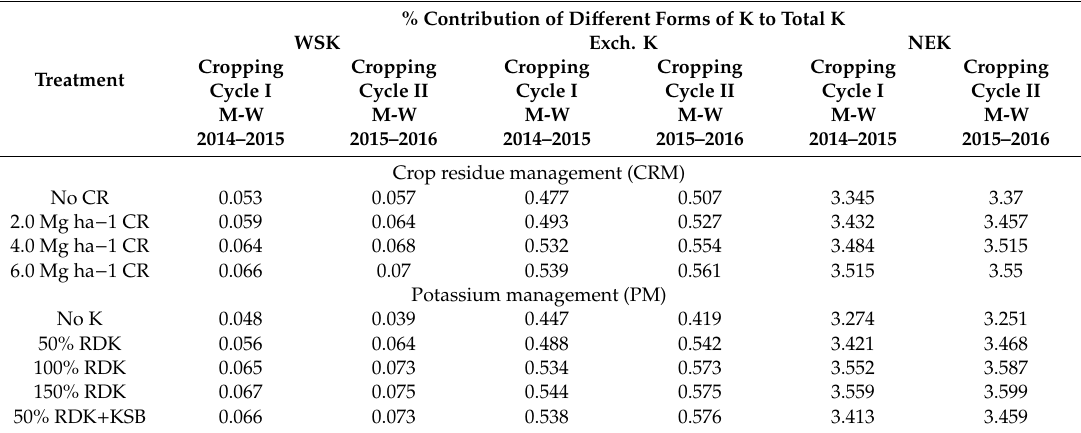
Table 8. Crop residue and potassium management on percent (%) contribution of di ff erent forms of K to total K in zero tillage maize–wheat system. % Contribution of Di ff erent Forms of K to Total K WSK Exch. K NEK Cropping Cropping Cropping Treatment Cycle I Cycle II Cycle